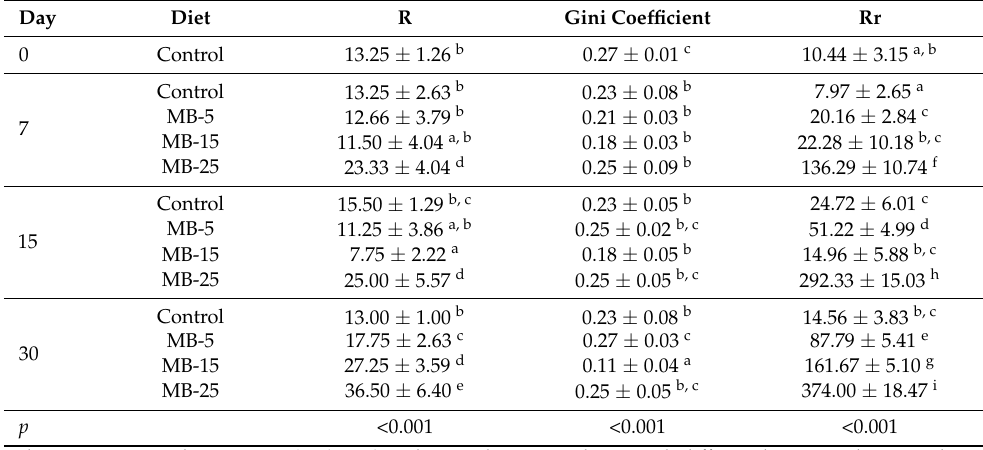
Table 7. Species richness (R), Gini coefficient, and range-weighted richness (Rr) values of intestinal microbiota DGGE patterns of juvenile S. aurata fed experimental diets for 30 days.